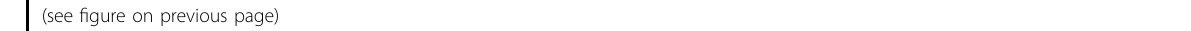
Fig. 1 Structural characterization of human SAGA complex. a , b Cryo-EM density map ( a ) and atomic model ( b ) of hSAGA complex are shown in front and back views. The cryo-EM map was segmented and colored according to different subunits of hSAGA complex and was shown at a contour level of 0.015 (SF3B3/5 was shown at a contour level of 0.009). c Overview of the core module. The histone octamer-like fold and the remainder structures are denoted, respectively. d Overall structural organization of the interface between ATXN7 and the core module. The ATXN7 segment is shown with EM density maps at a contour level of 0.015. e Structural comparison of hSAGA complex and yeast SAGA complex shows different binding ways of TRRAP and Tra1 to the core modules. f Overview of the binding path of SUPT20H on the surface of TRRAP. g Interface between TRRAP and the core module components, shown in front and back views. h Overall organization of the SF3B3/5 module within the complex. i Interface among SF3B3, SF3B5, and the HEAT repeat domain of TAF6L. j Structural superposition of the core modules of hSAGA complex and yeast SAGA complex reveals different organizations of the N-terminal domains of human TAF5L and yeast Taf5 in the two